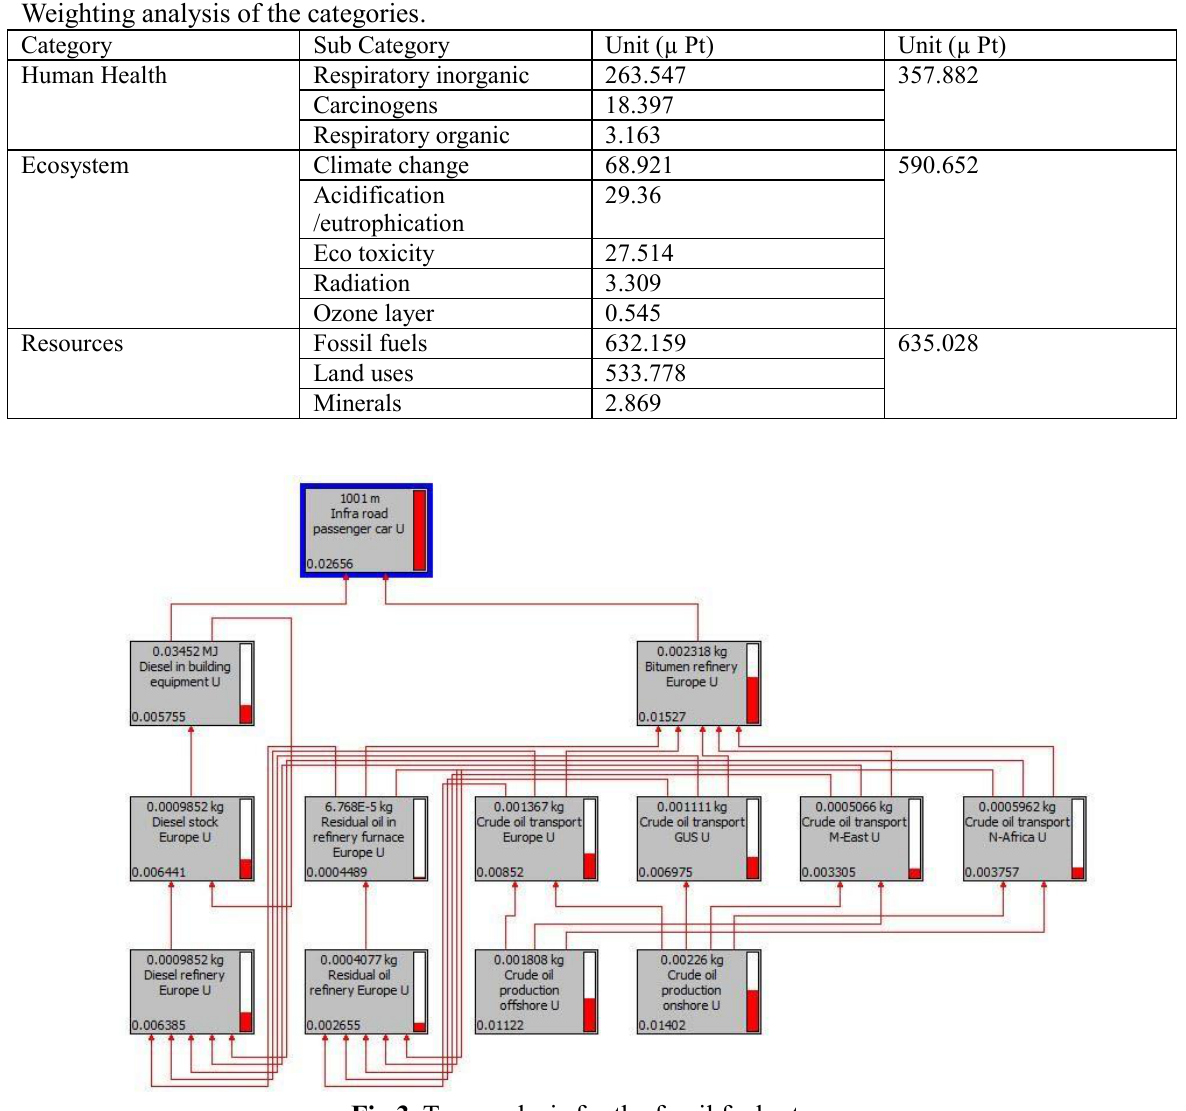
Fig 3. Tree analysis for the fossil fuels stream.